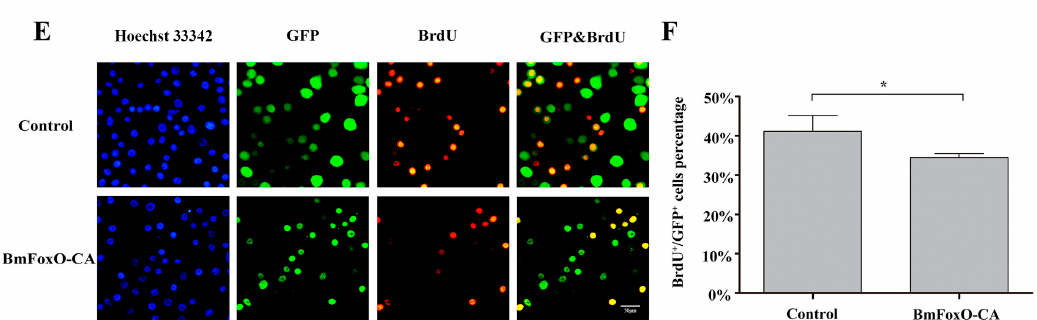
Figure 4. BmFoxO gene regulates DNA replication and cell cycle progression. ( A ) BmN-SWU1 cells were transfected with pIZ-BmFoxO-EGFP plasmids or pIZ-BmFoxO-CA-EGFP plasmids for 48 h. Immunofluorescence analysis of the localization of BmFoxO and BmFoxO-CA, separately. Nuclei were stained with Hoechst 33342. Scale bars, 10 µ m. ( B ) BmN-SWU1 cells were transfected with pIZ-BmFoxO-EGFP plasmids or pIZ-BmFoxO-CA-EGFP plasmids for 72 h. Western blot analysis of the localization of BmFoxO and BmFoxO-CA, separately. W represents whole cell lysates, C indicates the cytoplasmic proteins, and N shows the nuclear proteins. ( C ) Cell cycle analysis of BmN-SWU1 cells transfected with control plasmids or pIZ-BmFoxO-CA-EGFP plasmids by flow cytometry. ( D ) The cell proliferation ability of BmN-SWU1 cells transfected with control plasmids or pIZ-BmFoxO-CA-EGFP plasmids was detected by MTT assay at 24 h, 48 h, and 72 h (* p < 0.05, ** p < 0.01). ( E ) Anti-5-bromodeoxyuridine (anti-BrdU)-labeled BmN-SWU1 cells transfected with control plasmids or pIZ-BmFoxO-CA-EGFP plasmids. Green fluorescence represents positive transfected cells. Nuclei were stained with Hoechst 33342. Scale bars, 50 µ m. ( F ) Ratio of GFP positive cells labeled with BrdU (* p < 0.05, ** p < 0.01).